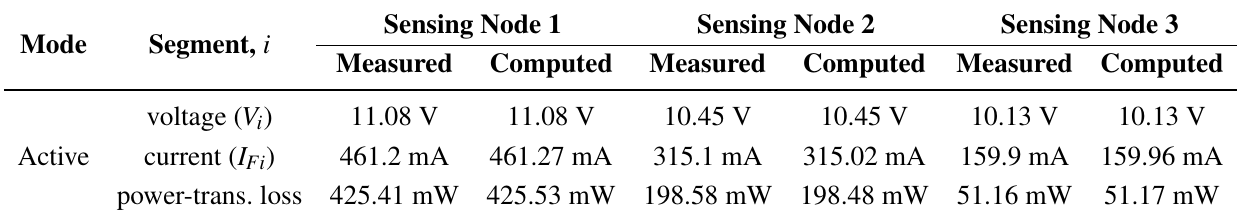
Table 2. Measured vs. computed voltage, current and power-transmission loss at V = 1 Ω and R L i